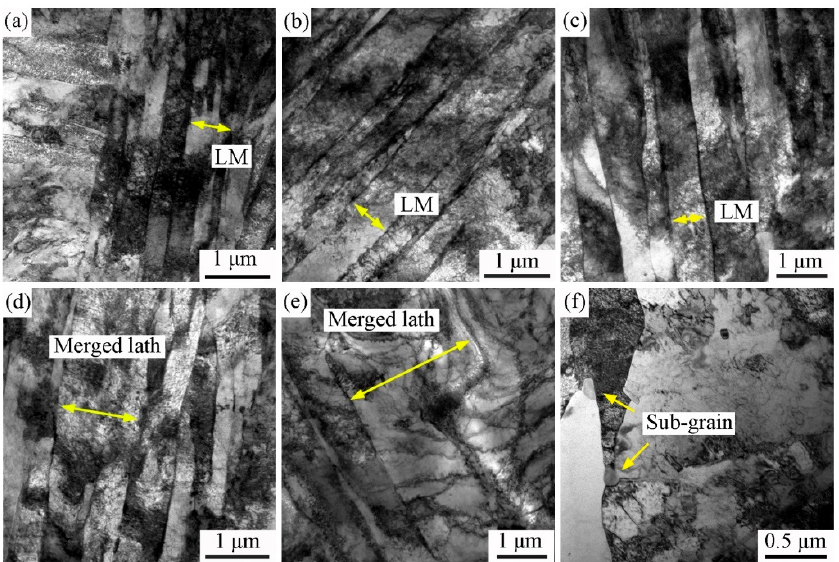
Figure 5. TEM micrographs of the specimens after different heat treatments. ( a ) WQ, ( b ) QT400, ( c ) QT450, ( d ) QT500, ( e ) QT550, ( f ) QT600.